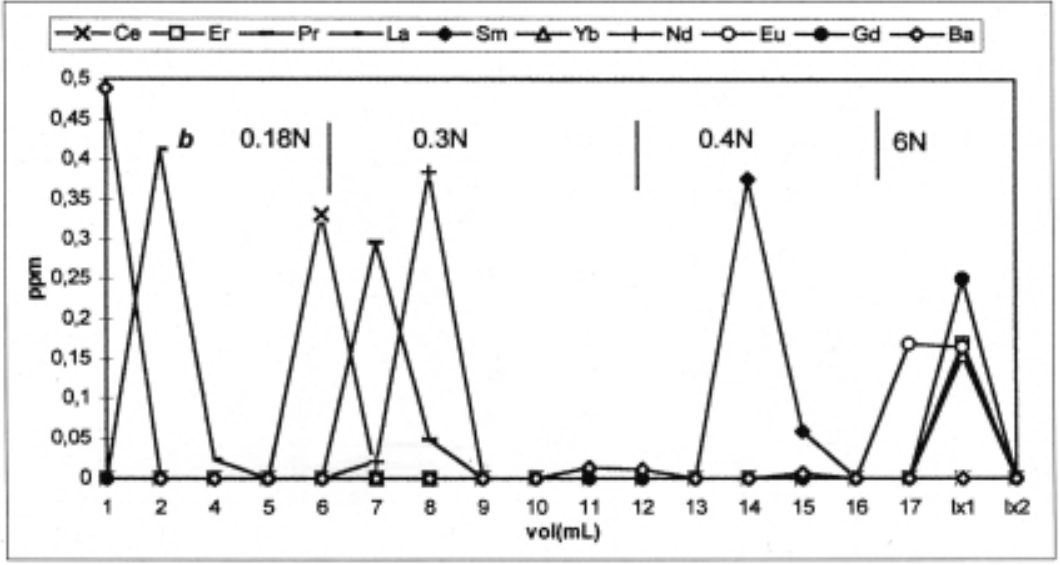
Fig. 3b – Columns calibration for minerals analysis: Sm and Nd separation.